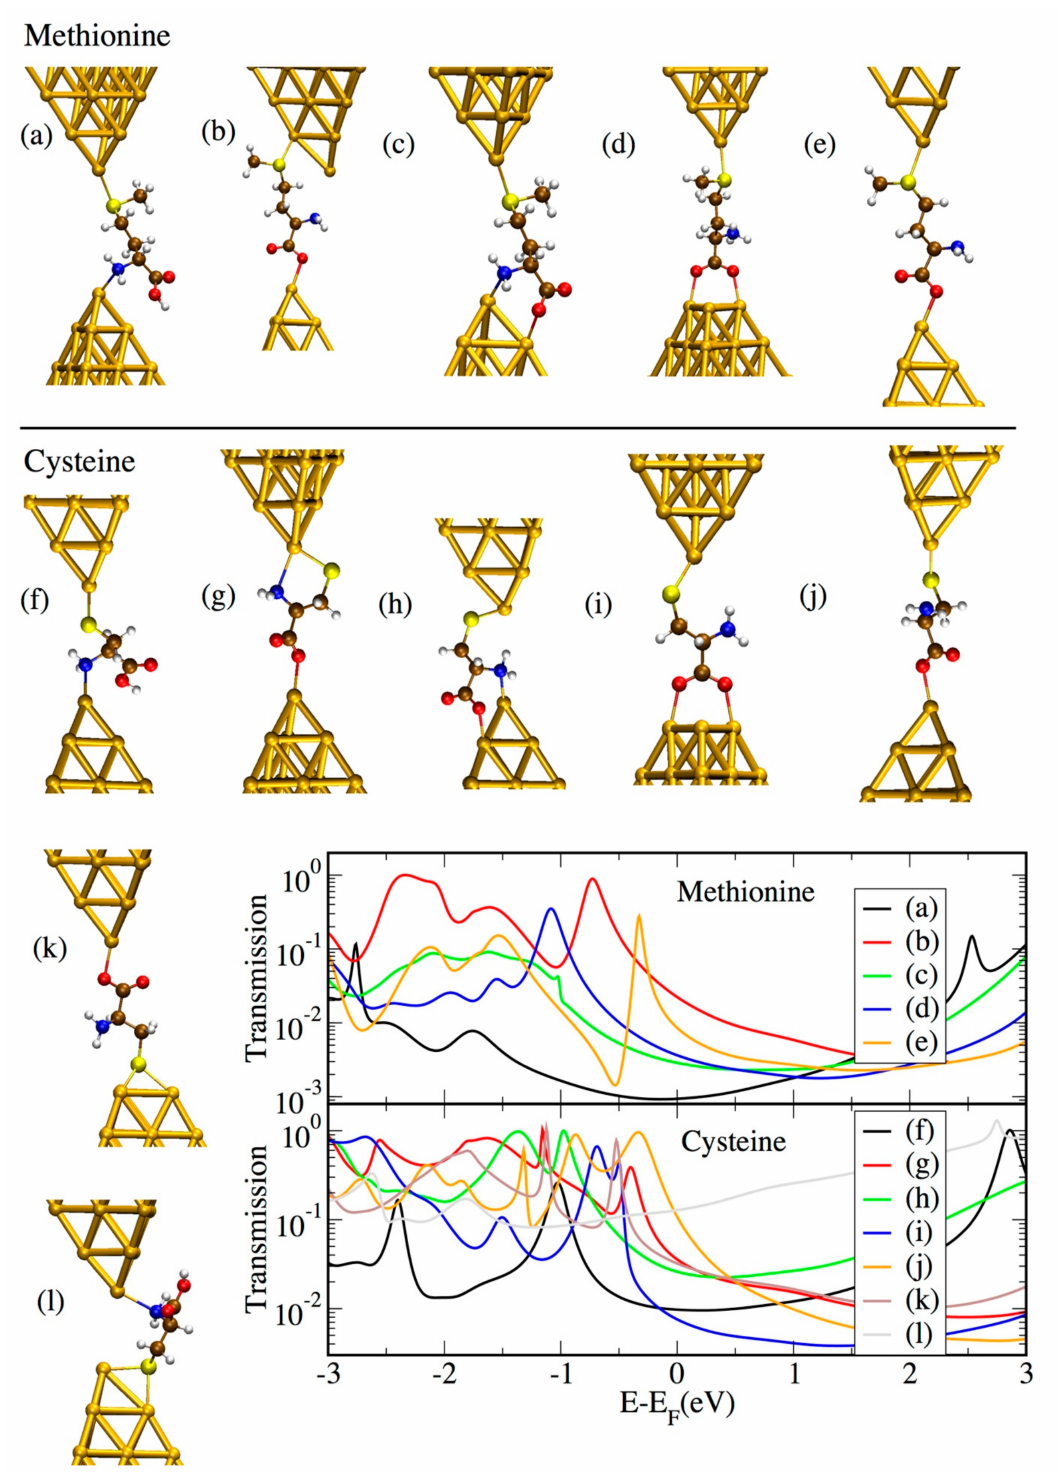
Figure 6. Analyzed geometries for junctions incorporating methionine ( a – e ) and cysteine ( f – l ) and corresponding transmission